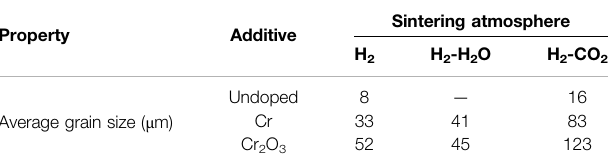
TABLE 7 | The average grain size of UO 2 pellets sintered in different oxygen potential atmospheres. Property